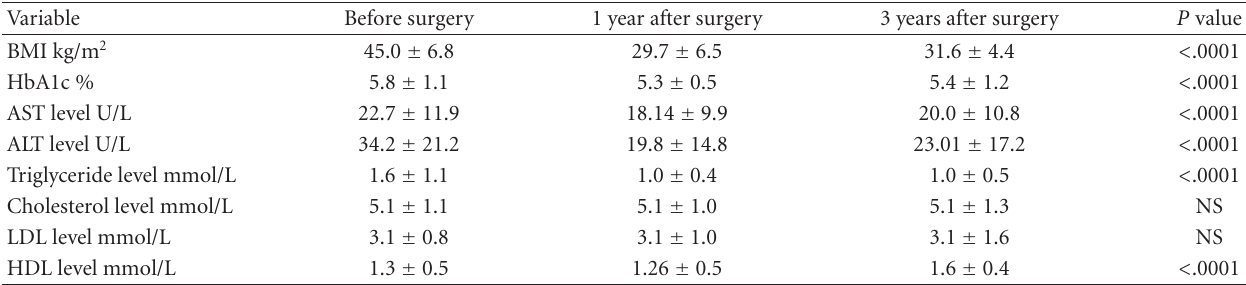
Table 2: Overall clinical and biological data at 1- and 3-year followup.